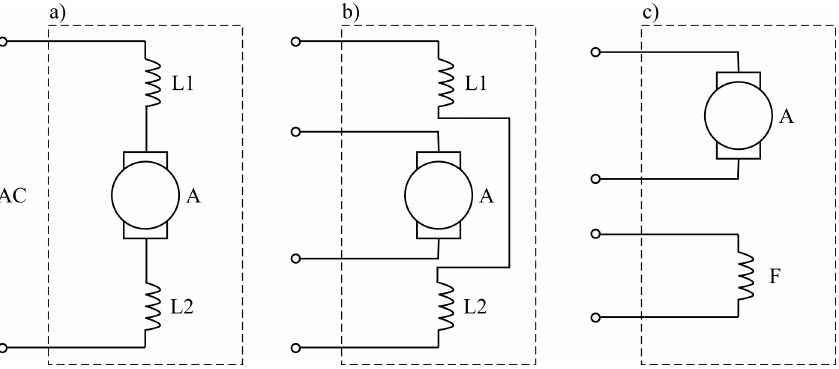
Figure 8. Field and armature coils, ( a ) series connection, ( b ) separate coils, and ( c )